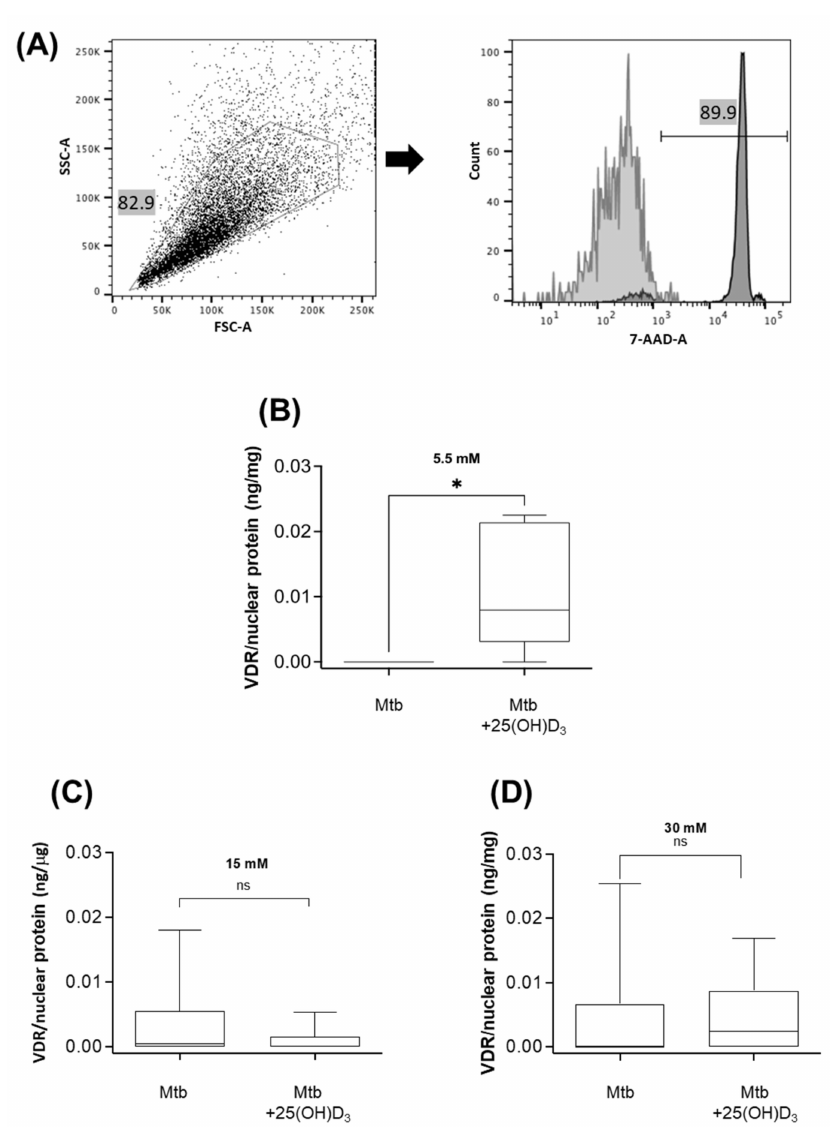
Figure 4. Effect of 25(OH)D 3 on VDR nuclear translocation in macrophages infected with M. tuber- culosis . Macrophages were cultured for 24 h in different glucose concentrations (5.5, 15, or 30 mM), infected with M. tuberculosis (MOI 1), supplemented with 25(OH)D 3 (1 µ M), and incubated for an additional 24 h. Nuclei were isolated and stained with 7-AAD for nuclei integrity verification by flow cytometry. Nuclei were gated according to their light scattering pattern. The histogram in light gray depicts the unstained sample (negative control), the histogram in dark gray depicts the 7-AAD stained sample of a representative experiment; 89.9% of the events were 7-AAD+ nuclei ( A ). Nuclear extracts were obtained from nuclei, and the vitamin D receptor (VDR) nuclear translocation was detected by ELISA. Box plots with individual results of cells in 5.5 mM ( B ), 15 mM ( C ), and 30 mM ( D ) glucose concentrations are depicted. ns: not significant, * p < 0.05, M. tuberculosis vs. M. tuberculosis + 25(OH)D 3 , one-tailed Wilcoxon